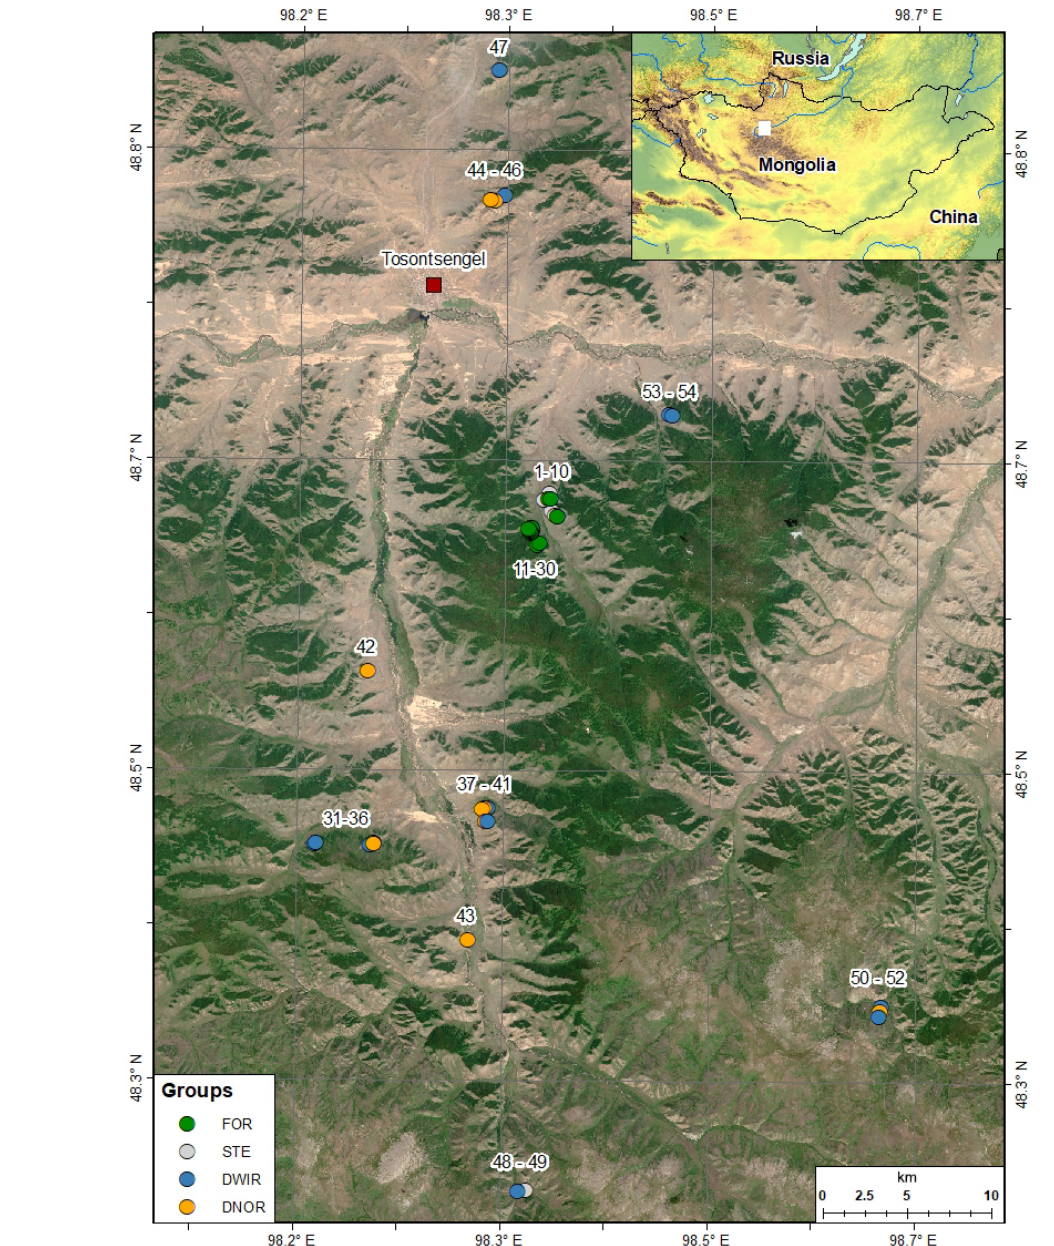
Figure 1. Sentinel image (31 July 2019) of the study area with soil profile positions. The colours indicate the four vegetation categories that were used for selecting the following soil profile locations: near-natural forest (FOR; green), steppe close to the forest (STE; grey), disturbed forest with regrowth of trees (DWIR; blue), and disturbed forest showing no regrowth of trees (DNOR; orange). The soil profiles are listed in Table 1 of the Appendix. The inset at the top right shows a physical map of Mongolia with the location of the study area (white